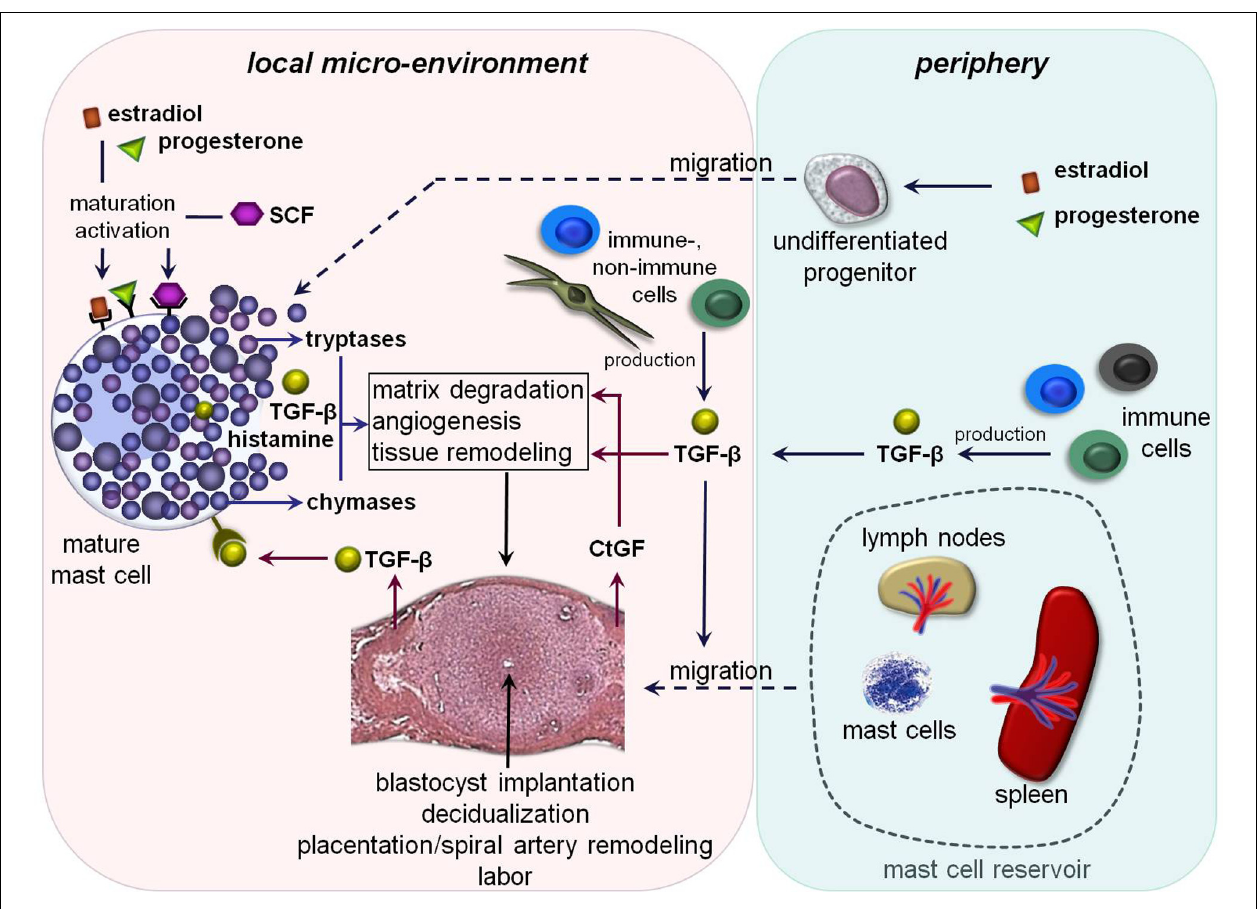
FIGURE 1 | Hypothetical scenario of MC-impact on pregnancy-related processes: undifferentiated MC-precursors migrate from the periphery into the uterus due to the simultaneous influence of estradiol and progesterone. Their local maturation and differentiation occurs through SCF. Amongst other mediators estradiol and progesterone could bind locally on uMCs that further lead to their activation.The MC-activation results in a simultaneous release of pre-formed and/or de novo synthesized mediators including different tryptases and chymases as well as transforming growth factor- β (TGF- β ) and histamine.These mediators could directly or indirectly